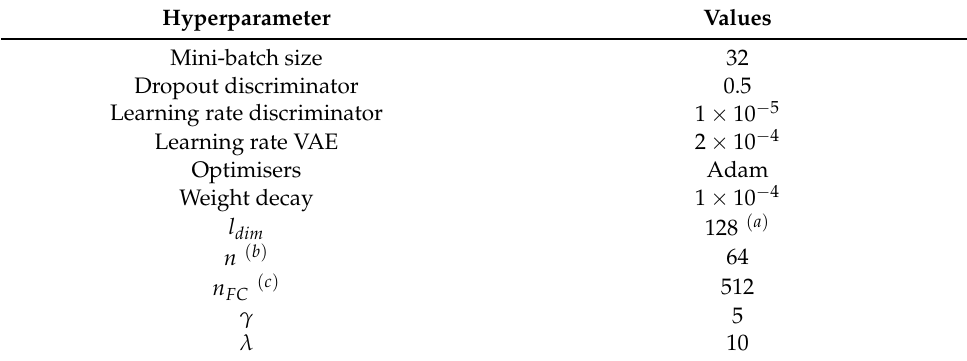
Table 5. Set of hyperparameters that led to the best-performing SSL